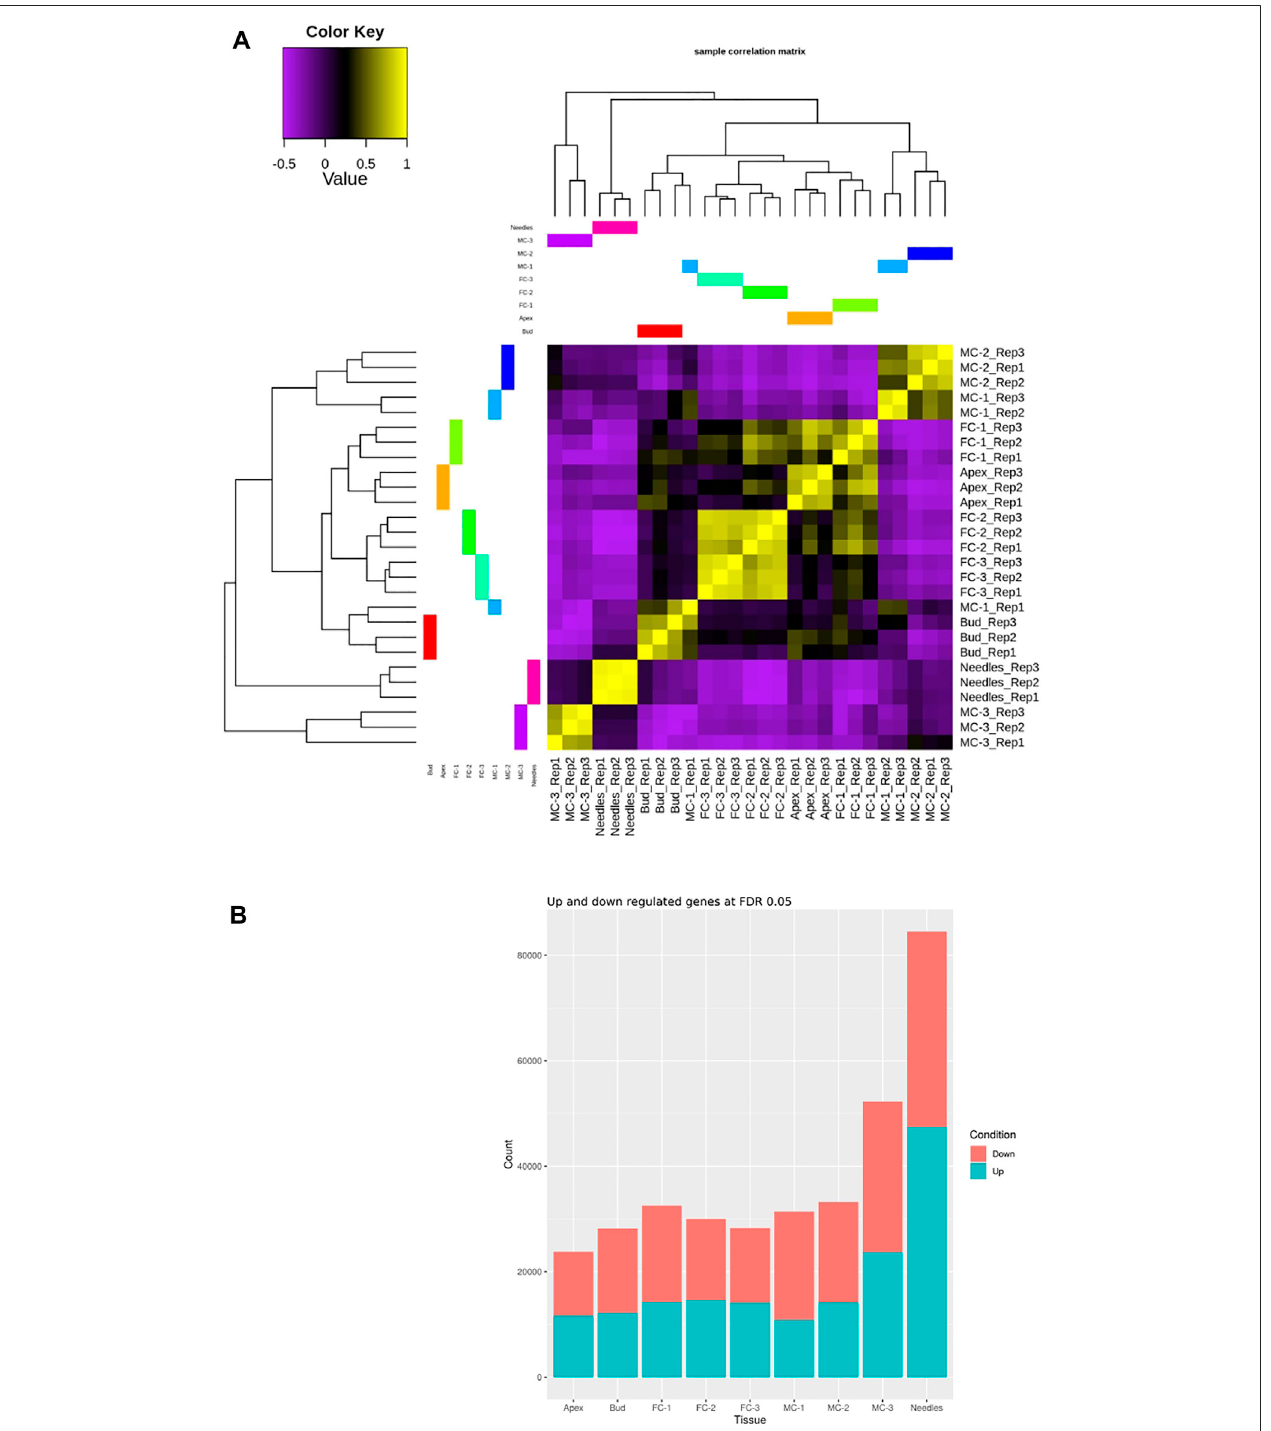
FIGURE 2 | Comparison of the transcriptome relationships and DEGs of the examined samples. (A) Correlation matrix of the transcriptome libraries of fi ve tissues and four time points (needles, buds, apex, MC-1, MC-2, MC-3, FC-1, FC-2, FC-3). (B) Sum of identi fi ed DEGs for each sample individually compared against all tissues and time points for a cutoff of logFC ≥ 2 and ≤ ( − 2), and FDR 0.05. The Needle tissue have more DEGs in comparison to any other tissue sampled.